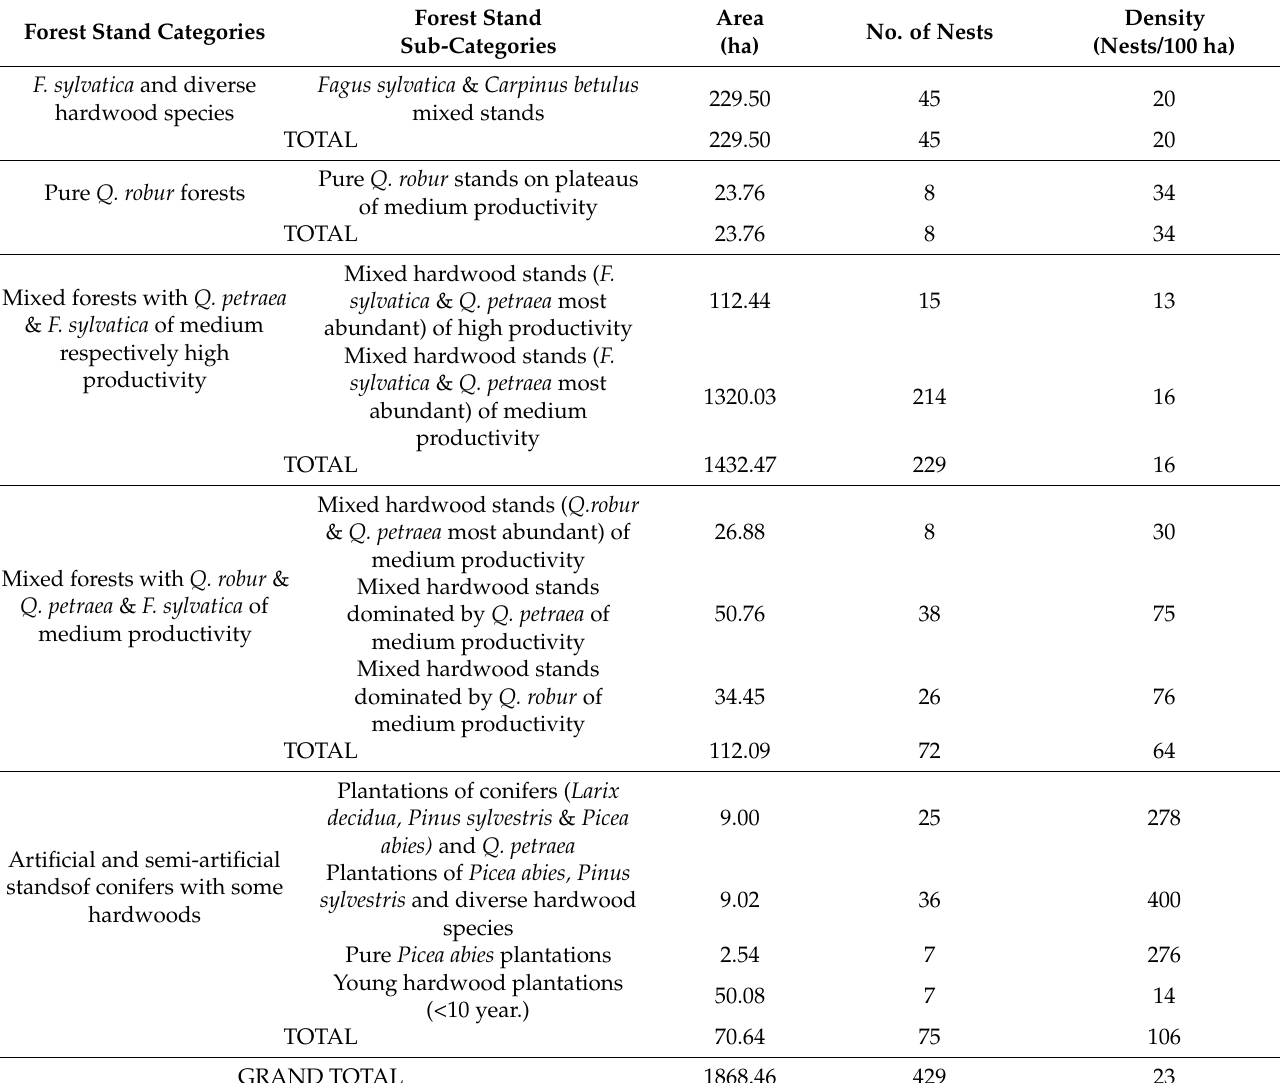
Table 2. RWA nest numbers and densities per 100 ha from 1960 in different types of forest stands (compiled from Pascovici [9,11]).